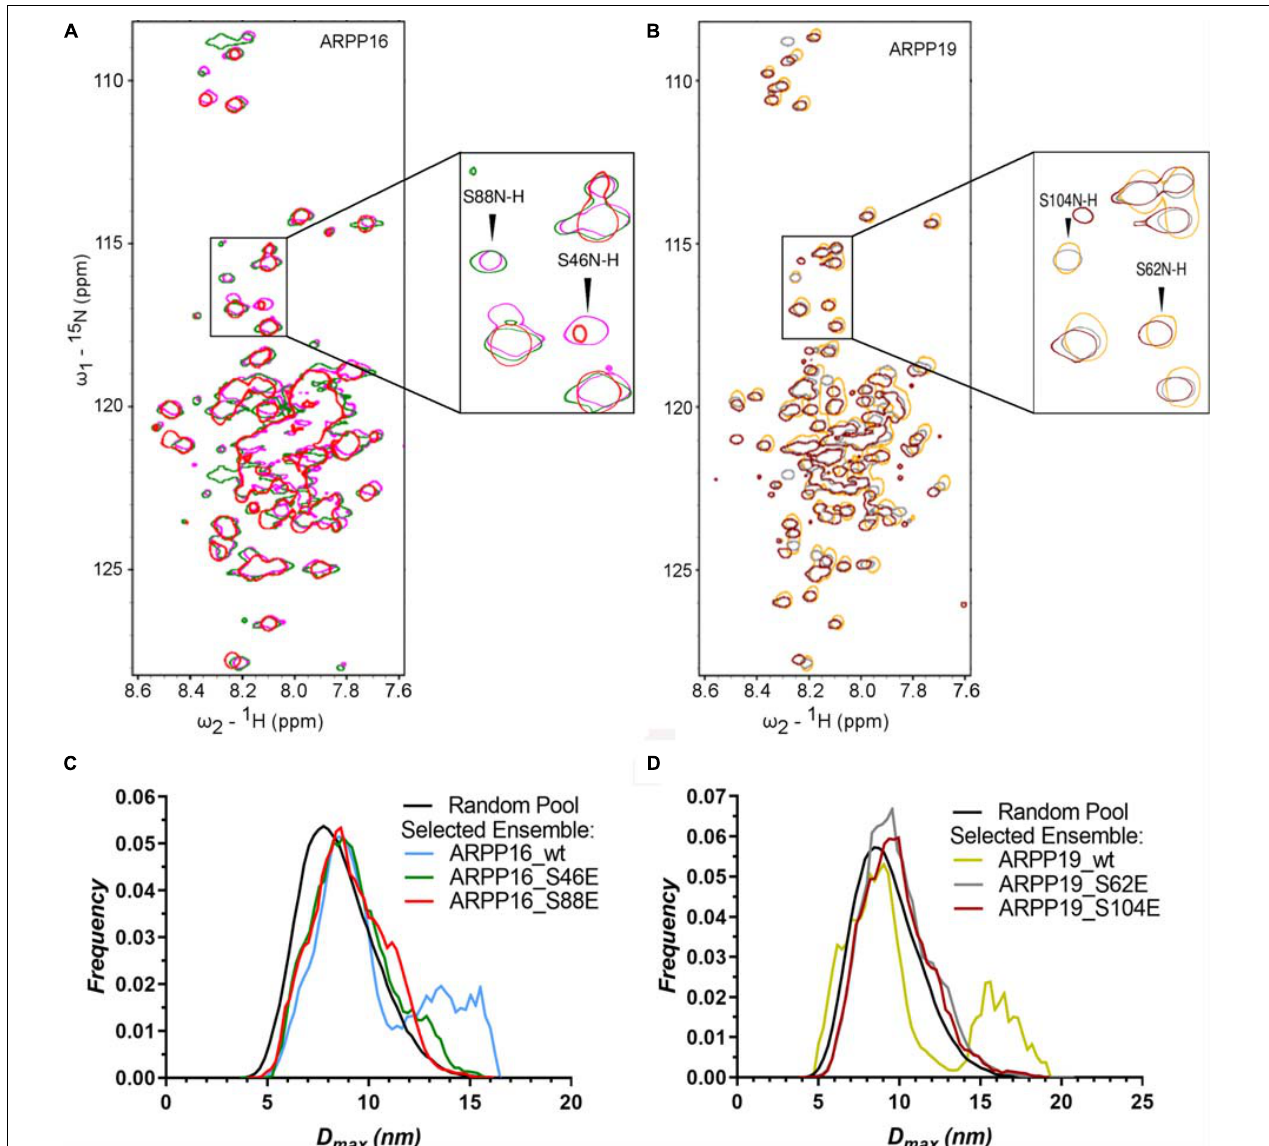
FIGURE 5 | The phosphorylation does not have significant effect on the structural properties of ARPPs. (A,B) The overlay 2D 15 N-HSQC spectra of uniformly 15 N labeled ARPP WT and phosphomutants reveals that the phosphomimicking mutations have no significant effect on ARPPs’ structural properties. The cross peaks in the 15 N-HSQC spectra of both ARPP-16 and ARPP-19 phosphomutants are highly similar to WT spectra, showing low dispersion of amide proton chemical shifts. This indicates that the ARPPs’ phosphomutants do not induce formation of well-defined 3D structure. (A) The spectrum of WT ARPP-16 is shown in magenta, ARPP-16 S46E and ARPP-16 S88E in green and red, respectively. (B) The spectrum of WT ARPP-19 is shown in orange, ARPP-19 S62E and ARPP-19 in gray and maroon, respectively. (C,D) D max distributions of ARPPs’ WT and phosphomutants ARPPs obtained from EOM analyses of the SAXS data plotted as function of frequency (a.u.) reveals that with phosphomutants, the extended conformation is less favored than with